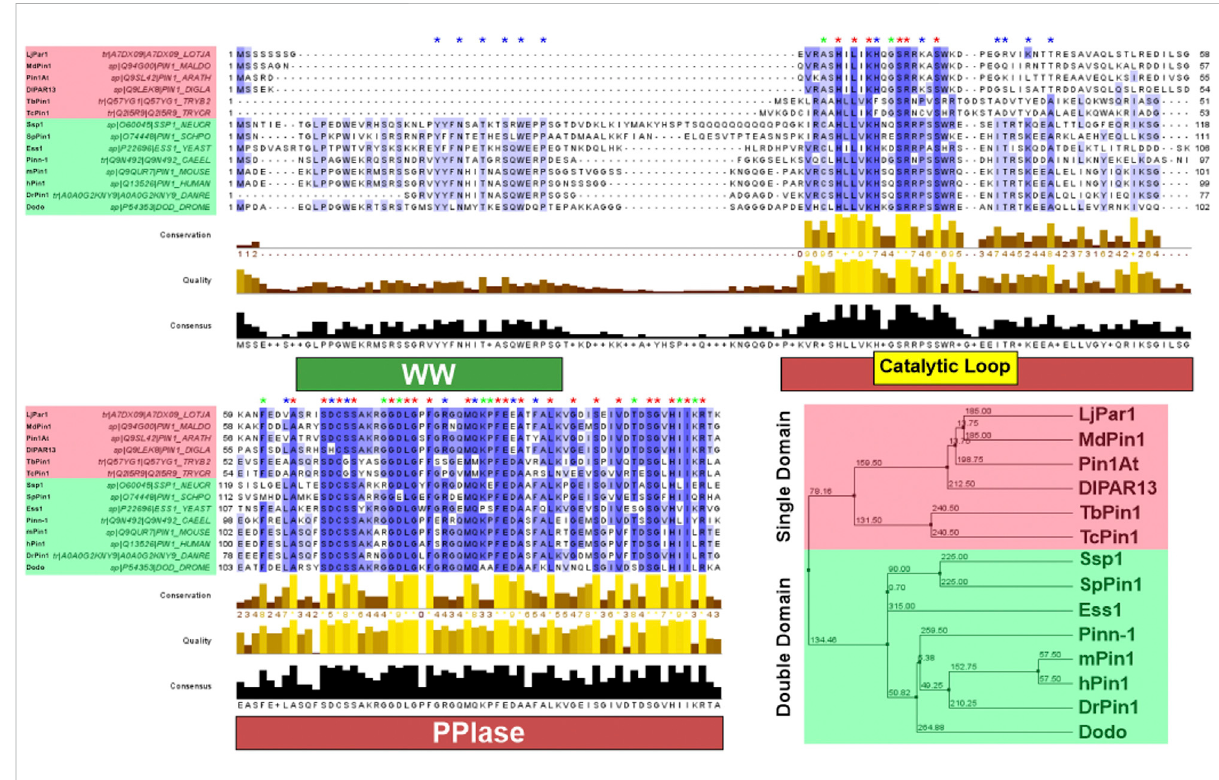
FIGURE 2 Pin1sequenceconservationacrossspecies. Pin1orthologshighlighted redhaveonlythePPIasedomain;Pin1orthologshighlightedgreenhave both the WW and PPIase domains. Blue asterisk above the sequence indicates conserved amino acid only in Pin1 orthologs with double domain; green asterisk indicates conserved amino acid only in Pin1 orthologs with single domain; red asterisk indicates conserved amino acid in all Pin1 orthologs. The purple highlight of the Pin1 orthologs ’ sequences indicates the degree of conservation across all Pin1 orthologs. A darker shade of purple demonstrates highly conserved amino acid across all Pin1 orthologs in that speci fi c position, while decreasing shade of purple demonstrates reduced conservation. Amino acid sequences of each Pin1 ortholog are obtained from UniProtKB and processed using Jalview 2.11.2.1. Sequence alignment was done using the ClustalWS algorithm with default settings, and the hierarchical tree was done using BLOSUM62 algorithmbasedonaveragedistance.Thedistances areindicatedinthetree.hPin1:HumanPin1;mPin1:MousePin1;DrPin1: Daniorerio Pin1; Pinn-1: C. elegans Pin1; Dodo: D. melanogaster Pin1; Ess1: S. cerevisiae Pin1; SpPin1: S. pombe Pin1; Ssp1: Neurospora crassa Pin1; LjPar1: L. japonicus Pin1; MdPin1: Malus domestica Pin1; Pin1At: A. thaliana Pin1; DlPar13: D. lanata Pin1; TcPin1: T. cruzi Pin1; TbPin1: T. brucei Pin1. The conservation histogram (top) re fl ects the conservation of the physicochemical properties of the amino acids, and absolutely conserved residues (max score 11) have a yellow asterisk “ * ” , and columns where physicochemical properties are conserved (score 10) have a yellow “ + ” ; less conserved positions are shown in darker colours with decreasing score. The quality histogram (middle) re fl ects the likelihood of observing a mutation in any particularcolumnofthealignmentbasedontheBLOSUM62matrixscores(foreachcolumn,thesumoftheratiosofthetwoBLOSUM62scoresfora mutation pair, and each residue ’ s conserved BLOSUM62 score, are normalised and plotted on a scale of 0 – 1). The consensus histogram (bottom) re fl ects the percentage of the modal residue per column, and the consensus sequence logo is shown for conserved regions ( “ + ” denotes non- conserved residues and “ - ” denotes gap